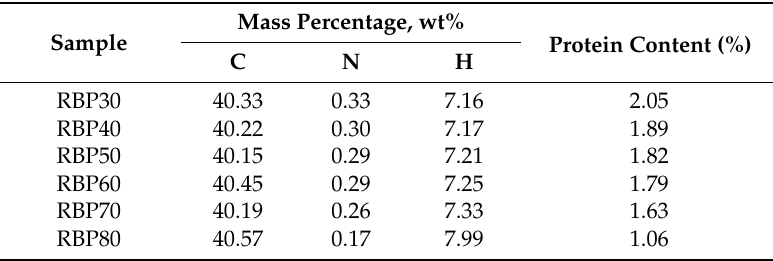
Table 4. Elemental analysis of RBPs Table 3. Elemental analysis of RBPs composites.